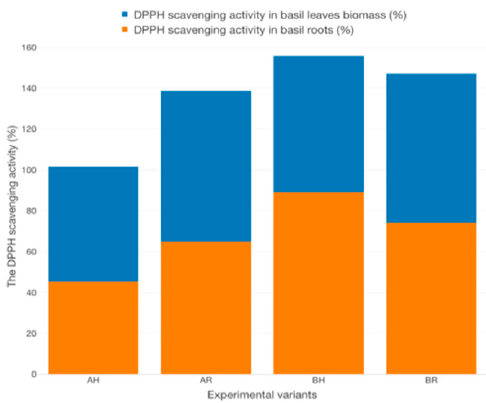
Figure 31. The DPPH scavenging activity in basil roots and leaves biomass growth in each of the experimental variants.